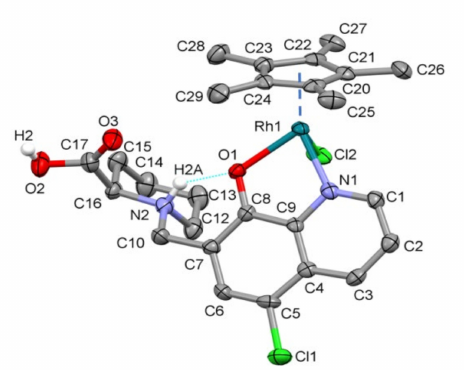
Figure 1. Molecular structure of [RhCp*(HQCl-D-hPro)Cl]Cl · H 2 O · CH 3 OH ( 1 ) with atom numbering. Displacement parameters are drawn at 50% probability level. Solvents, counter ion and hydrogen atoms are omitted for clarity (except homoproline proton H2A involved in intramolecular hydrogen bond (light blue solid line) and the proton on the carboxyl